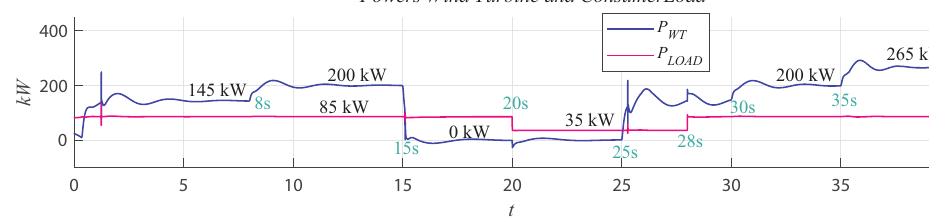
Figure 16. Power wind and load for case study 2.